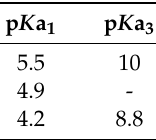
Table 1. The p K a values of Pyr-containing